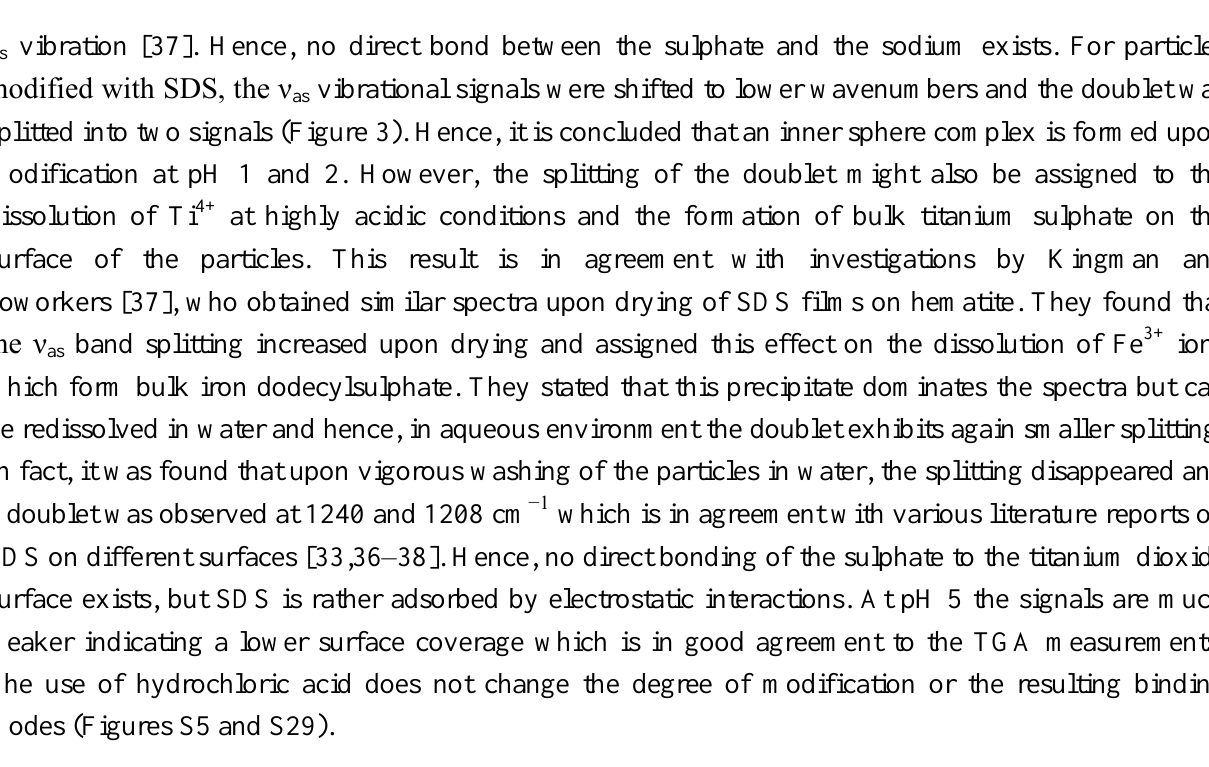
Figure 3. FT-IR (1600–700 cm −1 ) of SDS@TiO in HNO 3